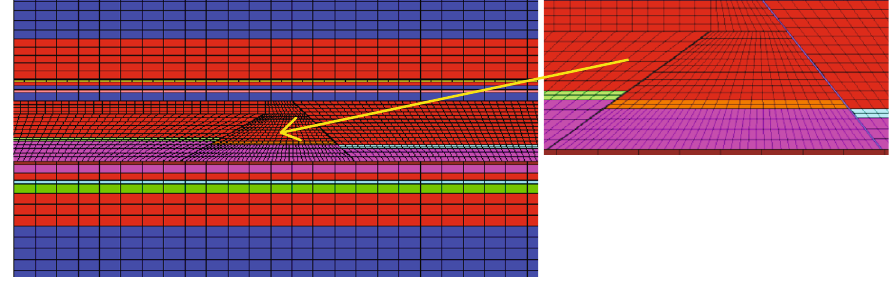
Figure 4: Model and local magni fi cation of the